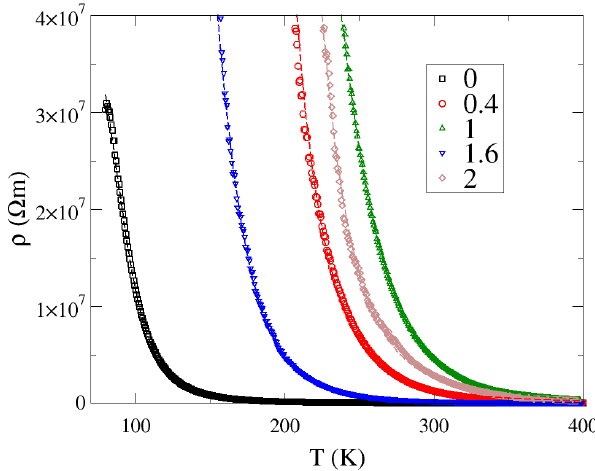
Figure 6. The resistivity of Zn 2 − x Mg x InV 3 O 11 (empty symbols) fitted using the parallel resistor model [23]. Table 1. Parallel resistor model fit of Zn 2 − x Mg x InV 3 O 11 (as seen in Figure 6).